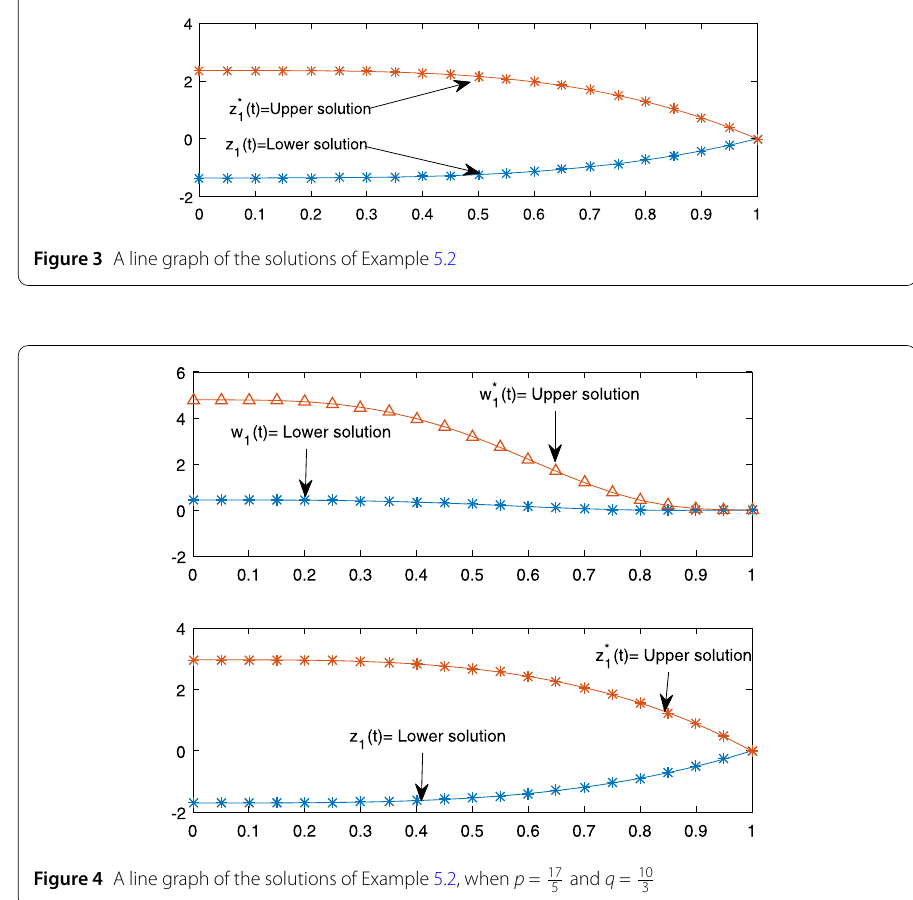
Figure 4 A line graph of the solutions of Example 5.2, when p = 17